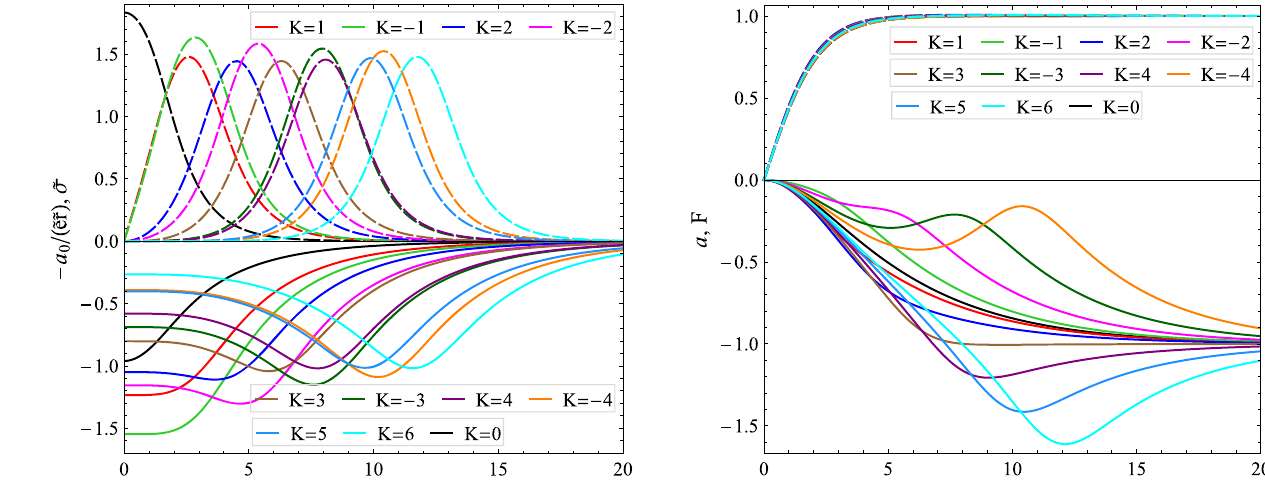
Fig. 13 Profilefunctions- a 0 /( ˜ e ˜ r ) (solidcurves)and ˜ σ (dashedcurves) of the vortex-Q-ball system for the first few azimutally excited states. The curves correspond to parameters ˜ ω = 0 . 7, ˜ m = 1, ˜ g = 1, ˜ h = 0 . 2, ˜ λ = 0 . 125, ˜ v = 2, ˜ e = ˜ q = 0 . 1, and N = 1